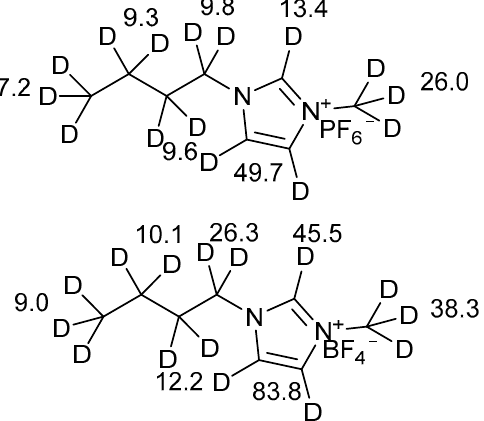
Figure 2. 1-n-butyl-3-methylimidazolium PF 6 − on top and the BF 4 − below. The numbers are the deuterium isotope effects from that particular set of deuterium seen at the fluorine signals of the counter ions. In the case of BF 4 − , the effects caused by D-2 and D-3 are actually also caused by D-5. Data for the aliphatic deuterations from Ref. [12] and those caused by deuteration at C-2, C-3 and C-5 from Ref. [13].